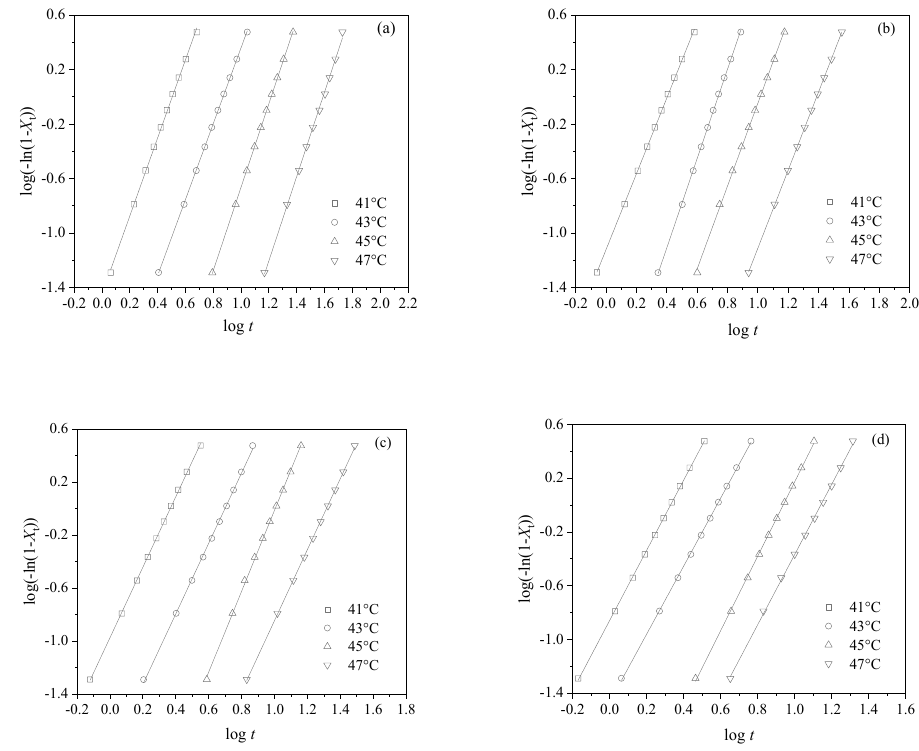
Figure 5. Avrami plots of ( a ) PHS, ( b ) PHS/CNC0.25, ( c ) PHS/CNC0.5, and ( d ) PHS/CNC1. Table 1 lists the summary of Avrami parameters for PHS and PHS/CNC composites. Regardless of T c and CNC content, n slightly varied between 2.5 and 3.3. The average n (2.85) was close to 3, indicating that PHS/CNC composites and PHS crystallized through the same crystallization mechanism within the investigated T c range, i.e., an athermal nucleation and three-dimensional truncated sphere growth mechanism [40]. For each sample, the k values gradually increased with the decrease in T c , indicating a shorter period of time required to complete crystallization. At the same T c , the k values increased with CNC content, suggesting that CNC promoted the crystallization of